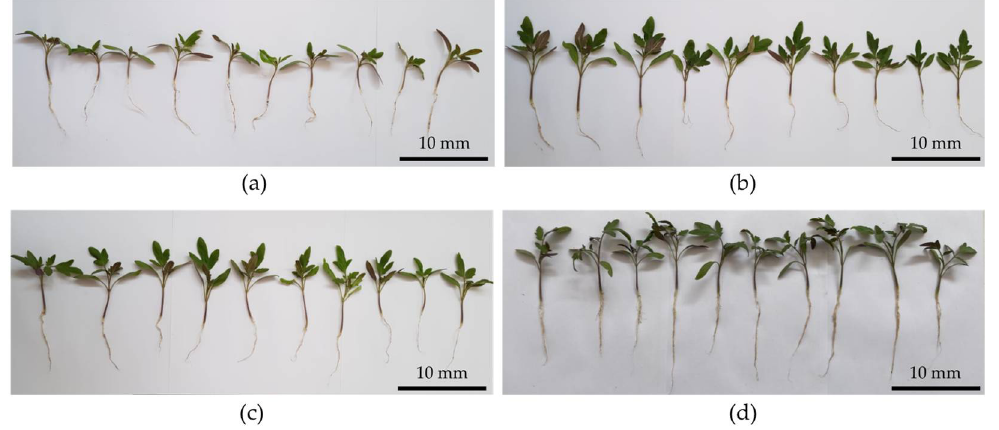
Figure 4. Phenotypes of tomato seedlings from seeds with and without bacterial inoculation. ( a ) Seedling from control treatment (without bacteria). Seedling from treatment inoculated with bacterial resuspension of ( b ) B. safensis RGM 2450, ( c ) B. siamensis RGM 2529, ( d ) mixture both bacterial strains (1:1). All the treatments were incubated for 21 d at 25 °C, with a 16:8 h light/dark photoper- iod.